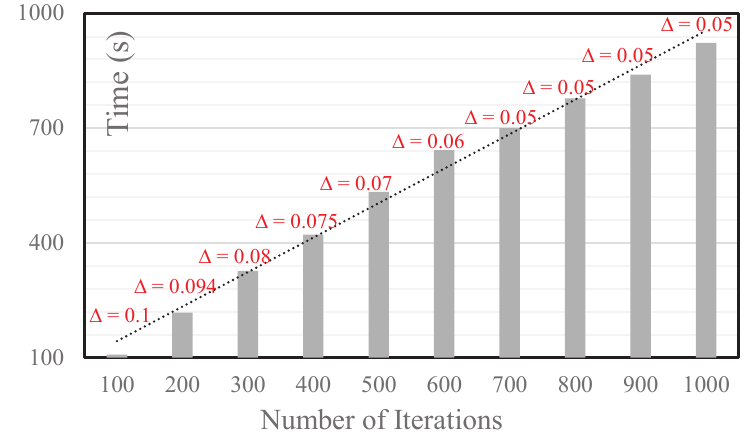
Figure 6. Iteration Number and Computational